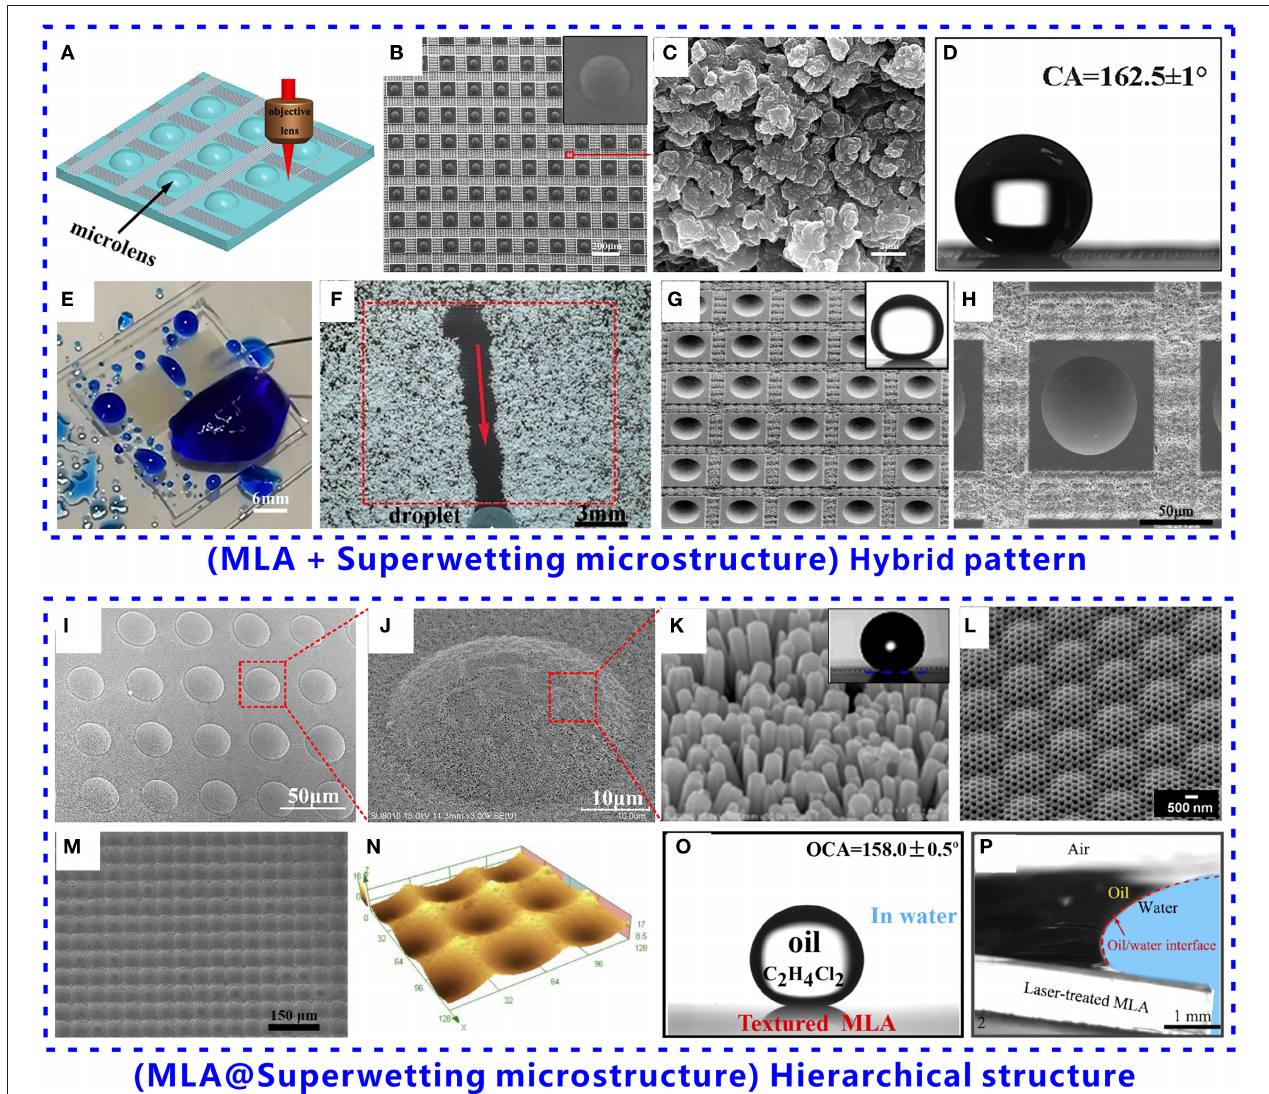
FIGURE 2 | Fabrication of superwetting MLAs and ACEs based on two strategies: (A–H) the hybrid pattern composed of the MLA domain and the superwetting domain and (I–P) the hierarchical structure of superwetting microstructures on the top surface of the microlenses. Superhydrophobic MLA pattern consisted of a convex MLA and the surrounding superhydrophobic microstructures on a PDMS surface: (A) schematic of generating superhydrophobic microstructures between microlenses by selective laser ablation, (B) SEM image of the as-prepared MLA pattern, (C) SEM image of the laser-induced microstructures on PDMS surface, (D) water droplet on the superhydrophobic MLA pattern, (E) remarkable water repellence of the superhydrophobic MLA, and (F) remarkable self-cleaning function of the superhydrophobic MLA. The inset in (B) shows the SEM image of a single microlens of the MLA pattern. (G,H) SEM images of an underwater superoleophobic MLA pattern consisted of a concave MLA and the surrounding laser-induced microstructures on a glass substrate. The inset in (G) shows an oil droplet on the underwater superoleophobic MLA pattern in a water medium. Superhydrophobic MLA with nanostructure on the top surface of the microlenses produced by crystal growth method: (I) SEM image of the hierarchical MLA structure, (J) SEM image of the surface of a single microlens, and (K) uniform nanorods grown on the surface of microlenses. The inset in (K) shows a water droplet on the hierarchical MLA pattern. (L) SEM image of the hierarchical MLA fabricated by the sacrificial layer mediated nanoimprinting. Formation of underwater superoleophobic micro/nanostructure on the top surface of the microlenses of an MLA: (M) SEM image of the underwater superoleophobic MLA, (N) 3D profile of the MLA, (O) oil droplet on the MLA surface in water, and (P) self-cleaning ability of the underwater superoleophobic MLA as the oil-polluted MLA is dipped into the water. Reproduced from Li M. et al. (2019a) with the permission of the WILEY-VCH. Reproduced from Bian et al. (2020) with the permission of Bian et al. Reproduced from Raut et al. (2015) and Li J. et al. (2019) with the permission of the American Chemical Society. Reproduced from Li M. et al. (2019b) with the permission of Li et